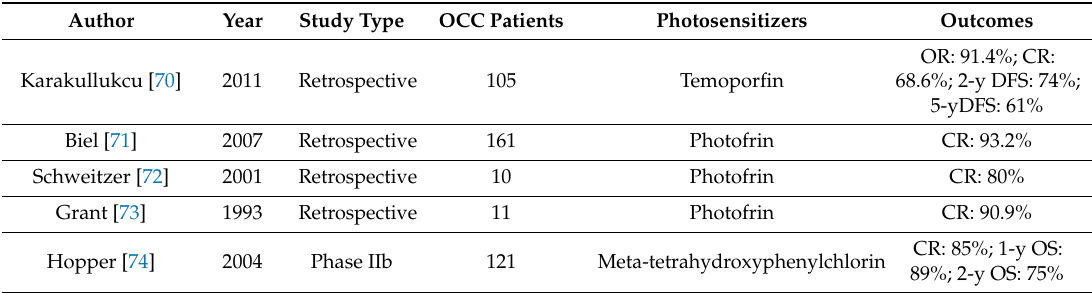
Table 3. Photodynamic therapy in the treatment of oral cavity